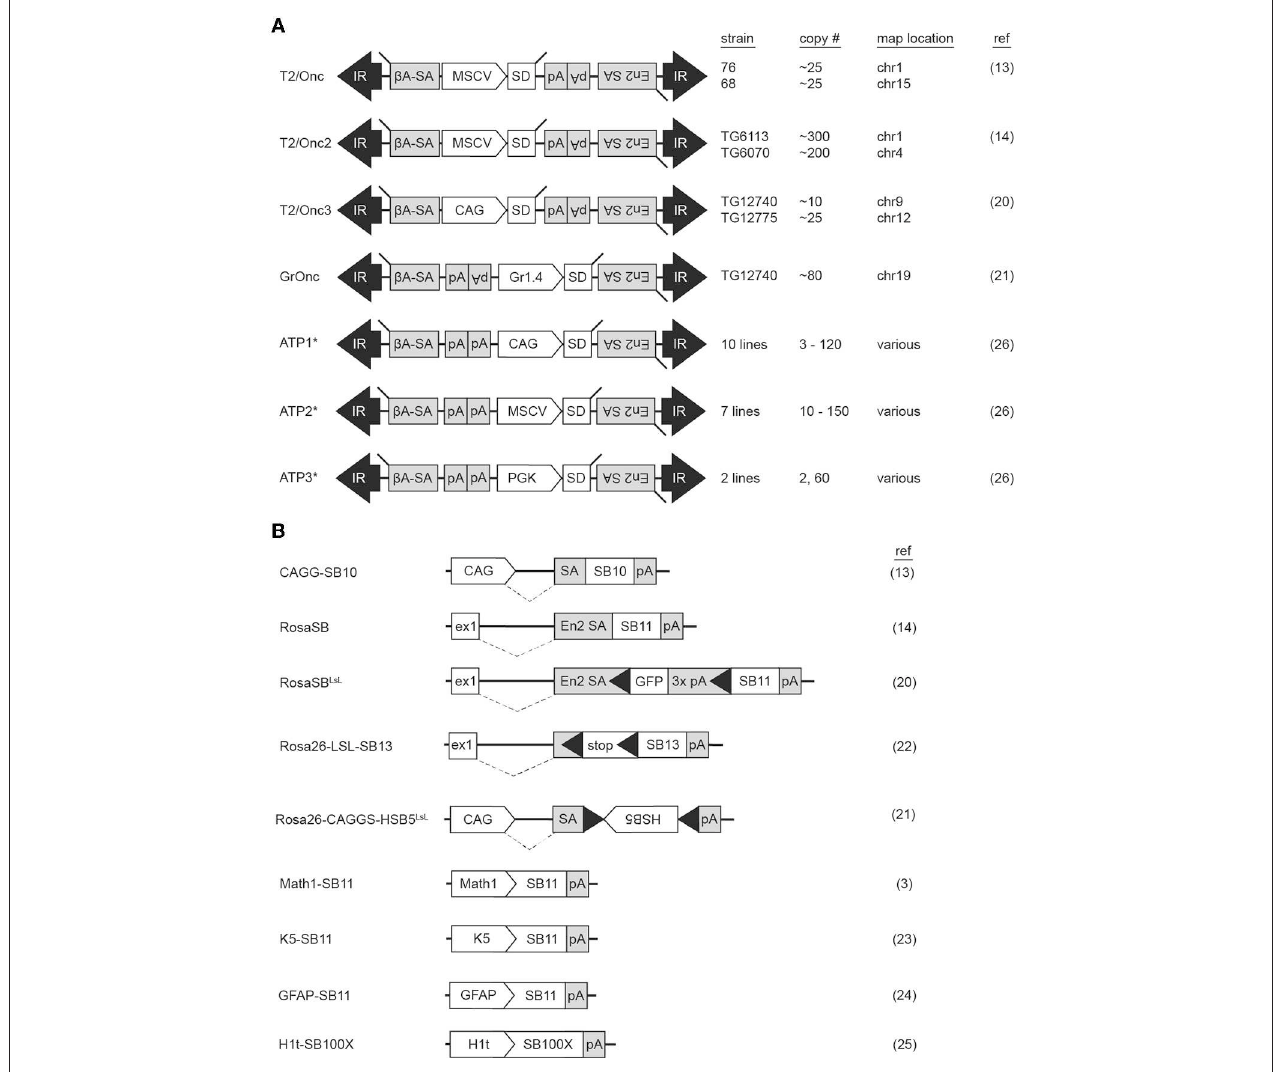
FIGURE 1 | Multiple Sleeping Beauty constructs have been engineered into mouse lines for use in forward genetic screens. Mouse strains harboring transposon (A) or transposase (B) constructs are available for use in forward genetic cancer screens. Transposition is initiated when a mouse harboring a transposon concatemer is crossed with a mouse harboring a transposase. For most transposon constructs, multiple lines have been developed, each harboring a different number of transposons on a different chromosome (A) . Transposase constructs incorporate various modifications to regulate location of enzyme activation (B) . ßA-SA, beta-actin splice acceptor; CAG, CAG promoter; En2 SA, engrailed-2 splice acceptor; ex1, Rosa26 exon 1; Gr1.4, Graffi1.4 murine leukemia virus LTR; IR, inverted repeat; MCSV, murine stem cell virus promoter; pA, polyadenylation signal; PGK, phosphoglycerate kinase promoter; SD, splice donor. Black triangles within transposase constructs represent Lox sequence sites recognized by Cre recombinase. *The ATP constructs incorporate both Sleeping Beauty and PiggyBac